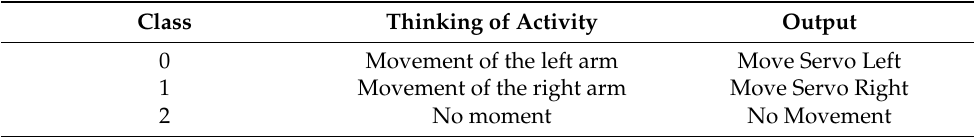
Table 3. Labeling the movement of the user and its predicted output.